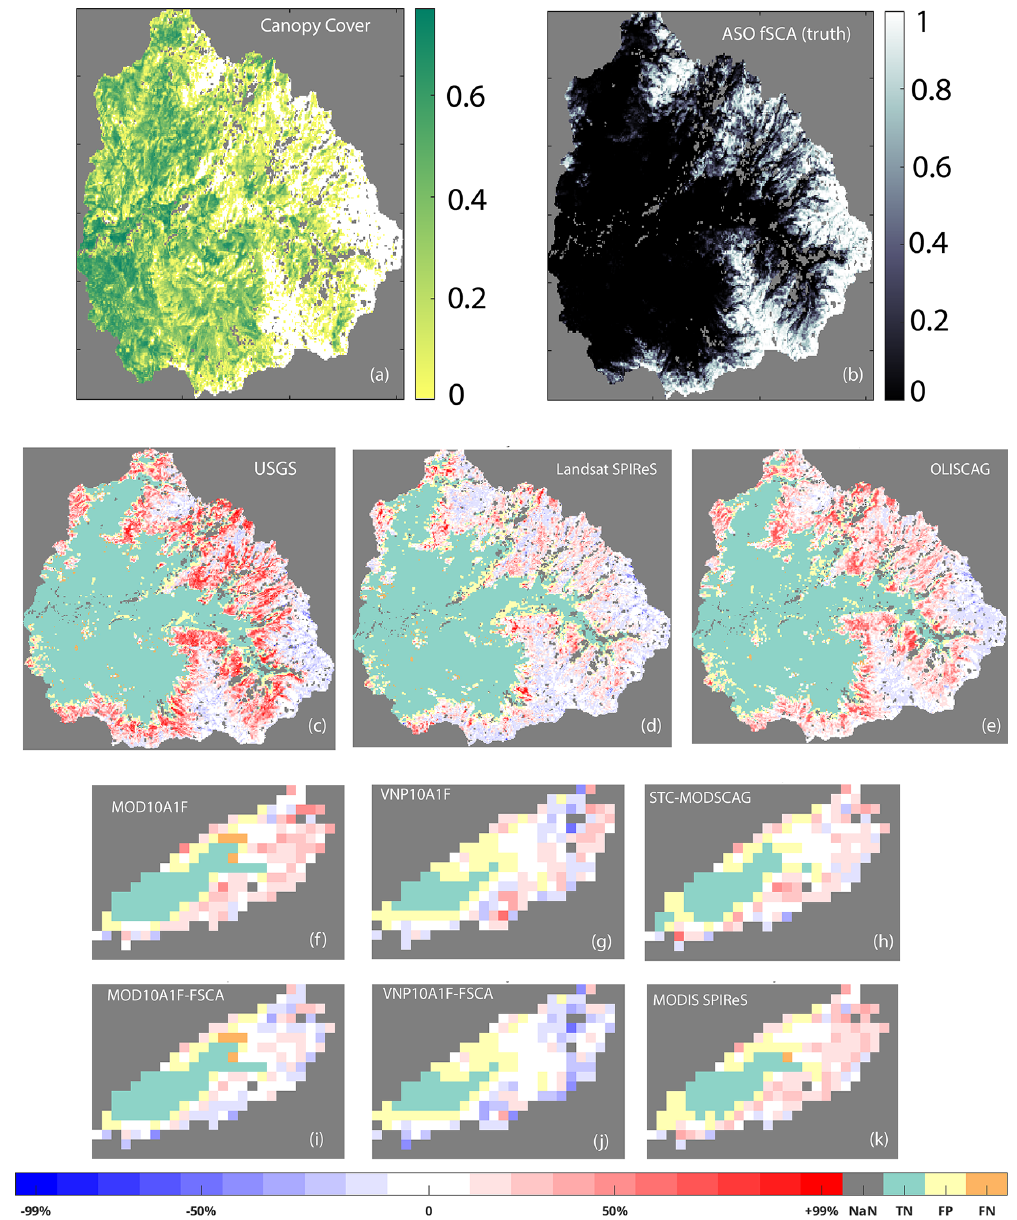
Figure 6. Merced River watershed, Sierra Nevada, California, on 7 May 2020; Yosemite Valley is approximately in the middle of these images displaying the 835km 2 watershed. Panel (a) shows the canopy cover fraction. Panel (b) shows the fSCA information obtained from ASO at a 120m pixel resolution. Panels (c) – (e) show comparisons of the Landsat products against the reference snow cover data from ASO at a 120m pixel resolution. Panels (f) – (k) display comparisons of the MODIS/VIIRS products at a 2km pixel resolution. The red, white, and blue pixels indicate locations where a product accurately detected snow cover (TP) but, compared to the ASO truth data, was found to have generated a positively biased result (red), an unbiased result (white), or a negatively biased result (blue). The orange pixels denote FNs (omission errors) in which the product did not correctly detect snow in the indicated location, while yellow pixels indicate FPs (commission errors) in which the algorithm incorrectly identified the presence of snow cover compared to the ASO truth dataset. The gray pixels (not-a- number (NaN) cells, outside the Merced basin) and green pixels (TNs) were not included in the analysis or used in any of the error statistic calculations performed in this paper. Note that the spatial projections differ (UTM for Landsat 8 vs. sinusoidal for MODIS and VIIRS) among the products in the panels, but all panels display the same